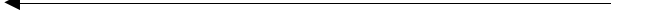
Fig. 5. Ion and electron measurements on 7 March 1997 between 21:10 and 21:50 UT. From top to bottom: energy-time spectrogram of electrons in the energy range 30 eV to 10 000 eV, energy-time spectrogram of protons in the energy range 30 eV to 14 000 eV and proton pitch-angle. Fluxes are color coded. The satellite altitude H in R , the invariant latitude (cid:76) in degrees, the magnetic local time MLT E 0 in hours, and the longitude : LONG in degrees, are given at the bottom of the figure. The electrons with energies lower than 70 eV detected before 21:24 UT are secondary